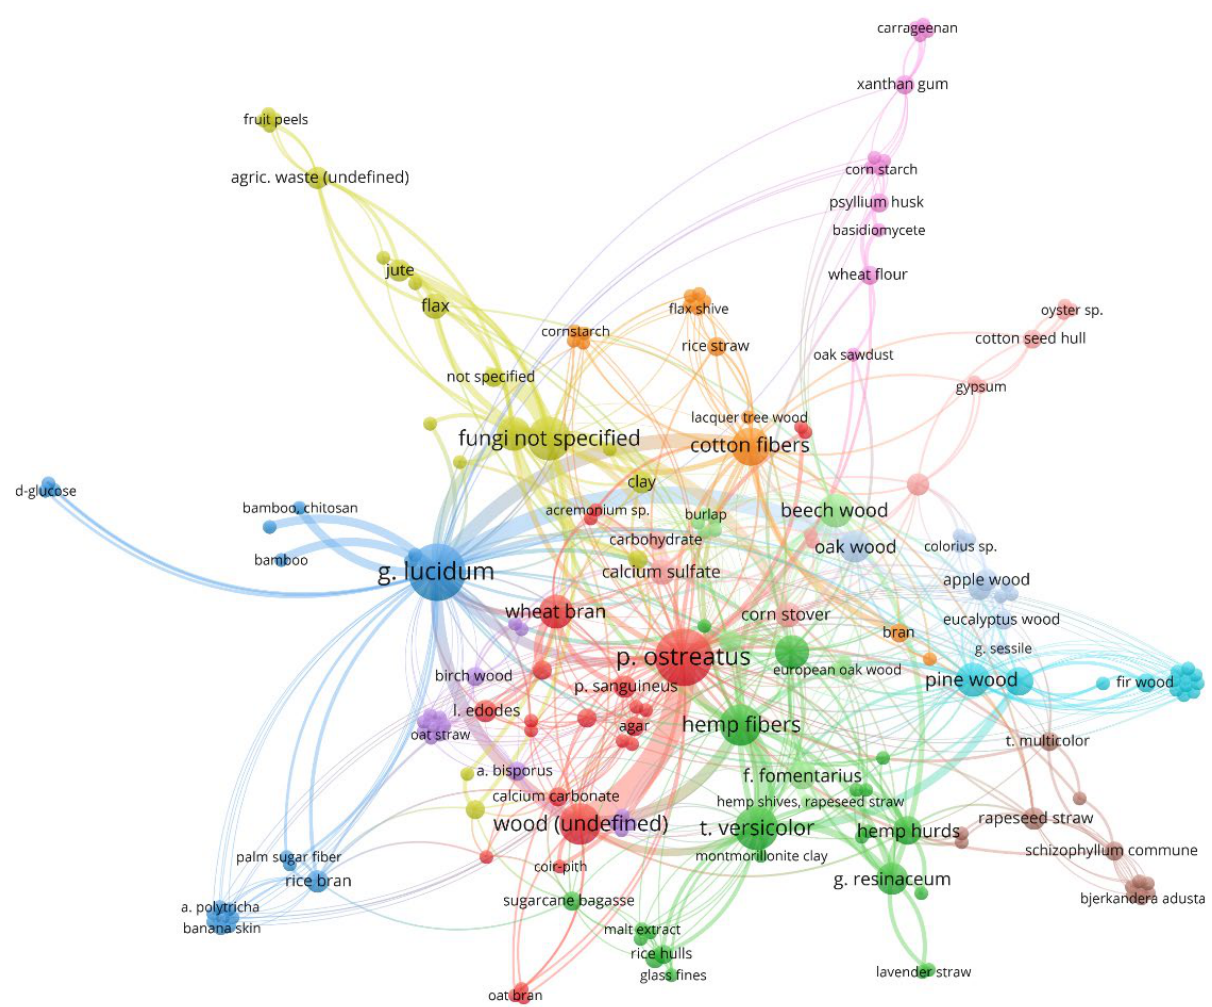
Figure 9. Combinations of substrates and fungus species used in scientific experiments.